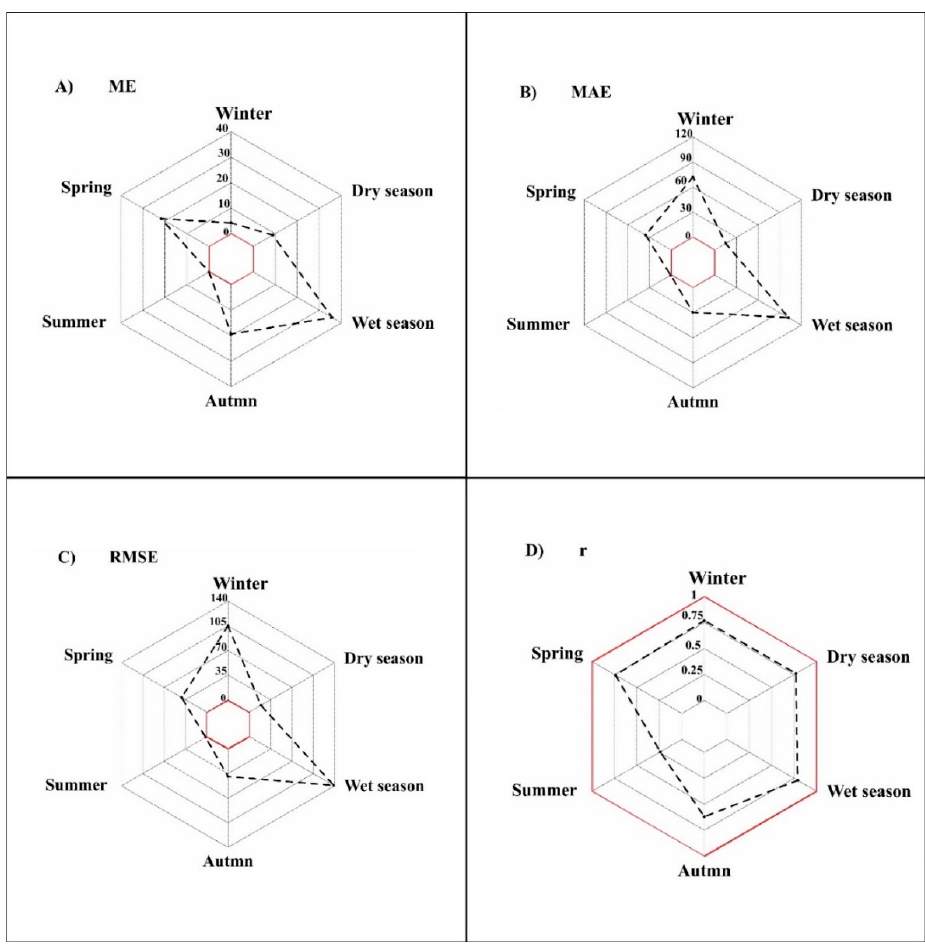
Figure 8. Accuracy statistics results at the seasonal scale in the Barada Basin between 2000 and 2020. Red lines indicate ideal values. Wet season is the accumulation of rainy months from October to end of March. Dry season is the accumulation of dry months from April to the end of September.